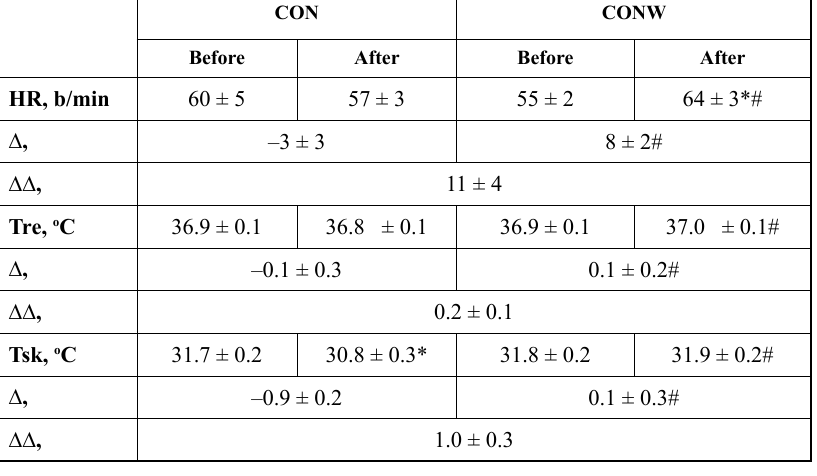
Table 1. Body temperatures and heart